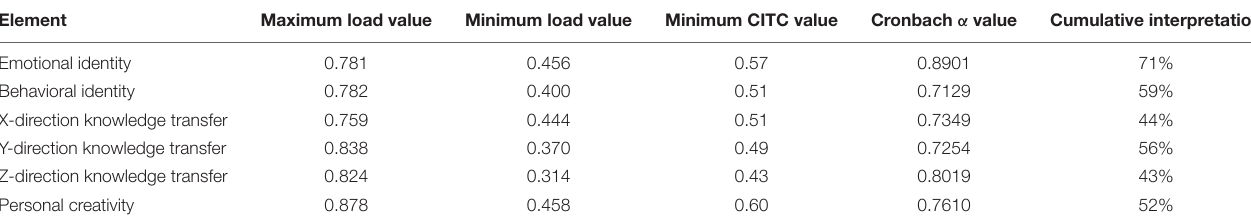
TABLE 2 | Reliability test results.